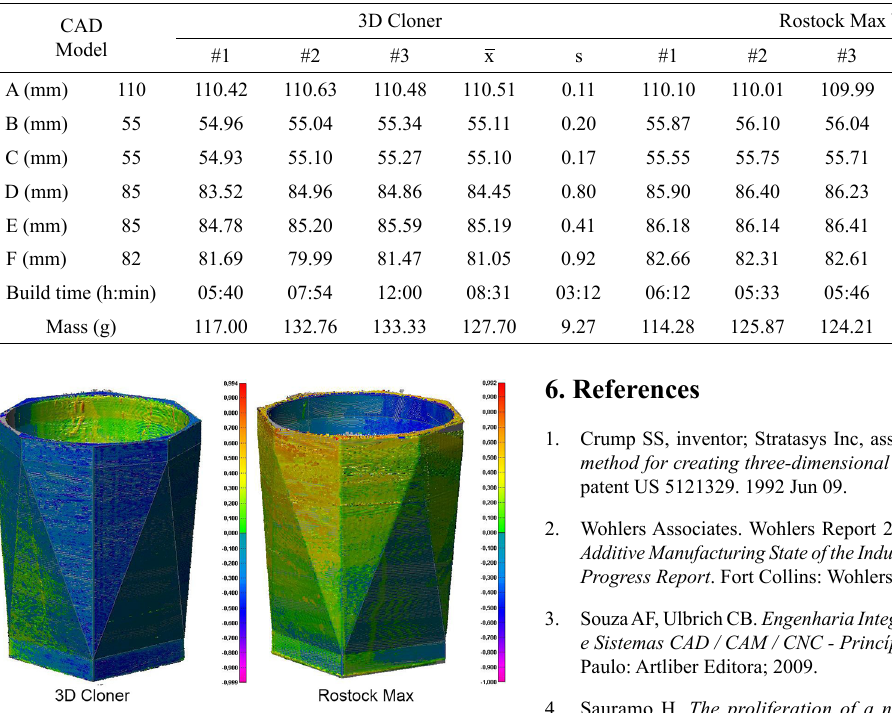
Figure 6. Comparative of CAD model and 3D printed